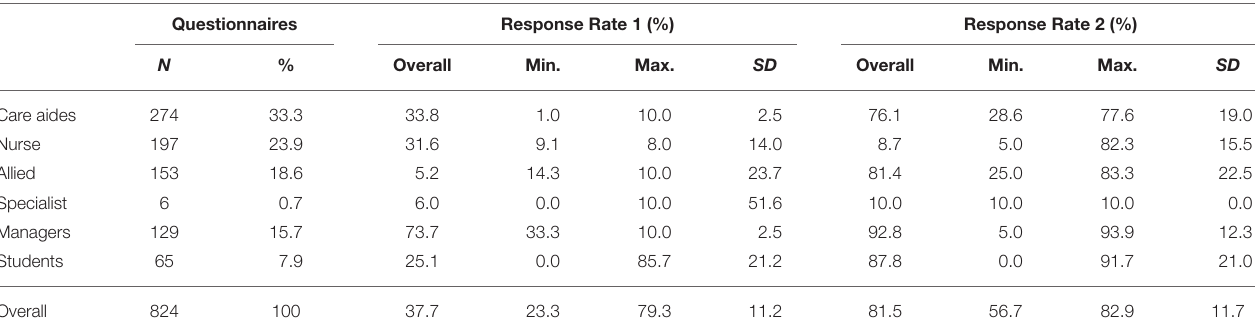
TABLE 4 | Response rates overall and by provider